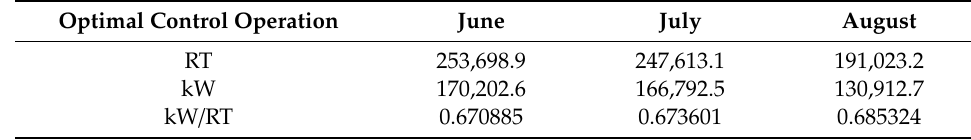
Table 3. System optimization control strategy involving FCU temperature